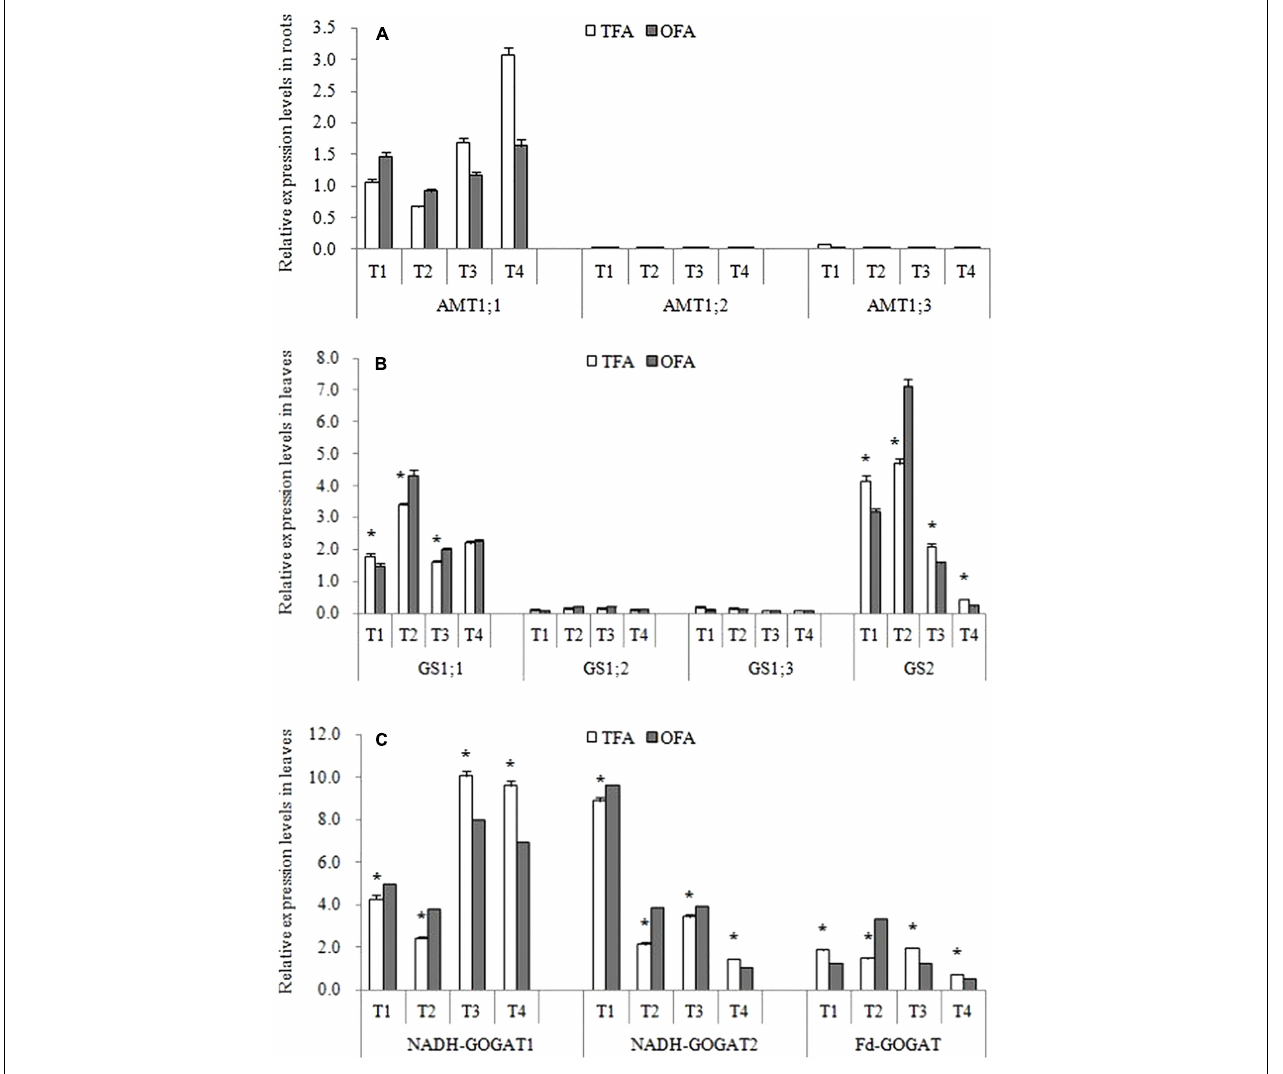
FIGURE 7 | Relative gene expression levels under various nitrogen source treatments (2016). (A) Relative expression levels of AMT in roots; (B) relative expression levels of GS in leaves; (C) relative expression levels of GOGAT in leaves. TFA: Traditional nitrogen fertilizer application; OFA: optimized nitrogen fertilizer